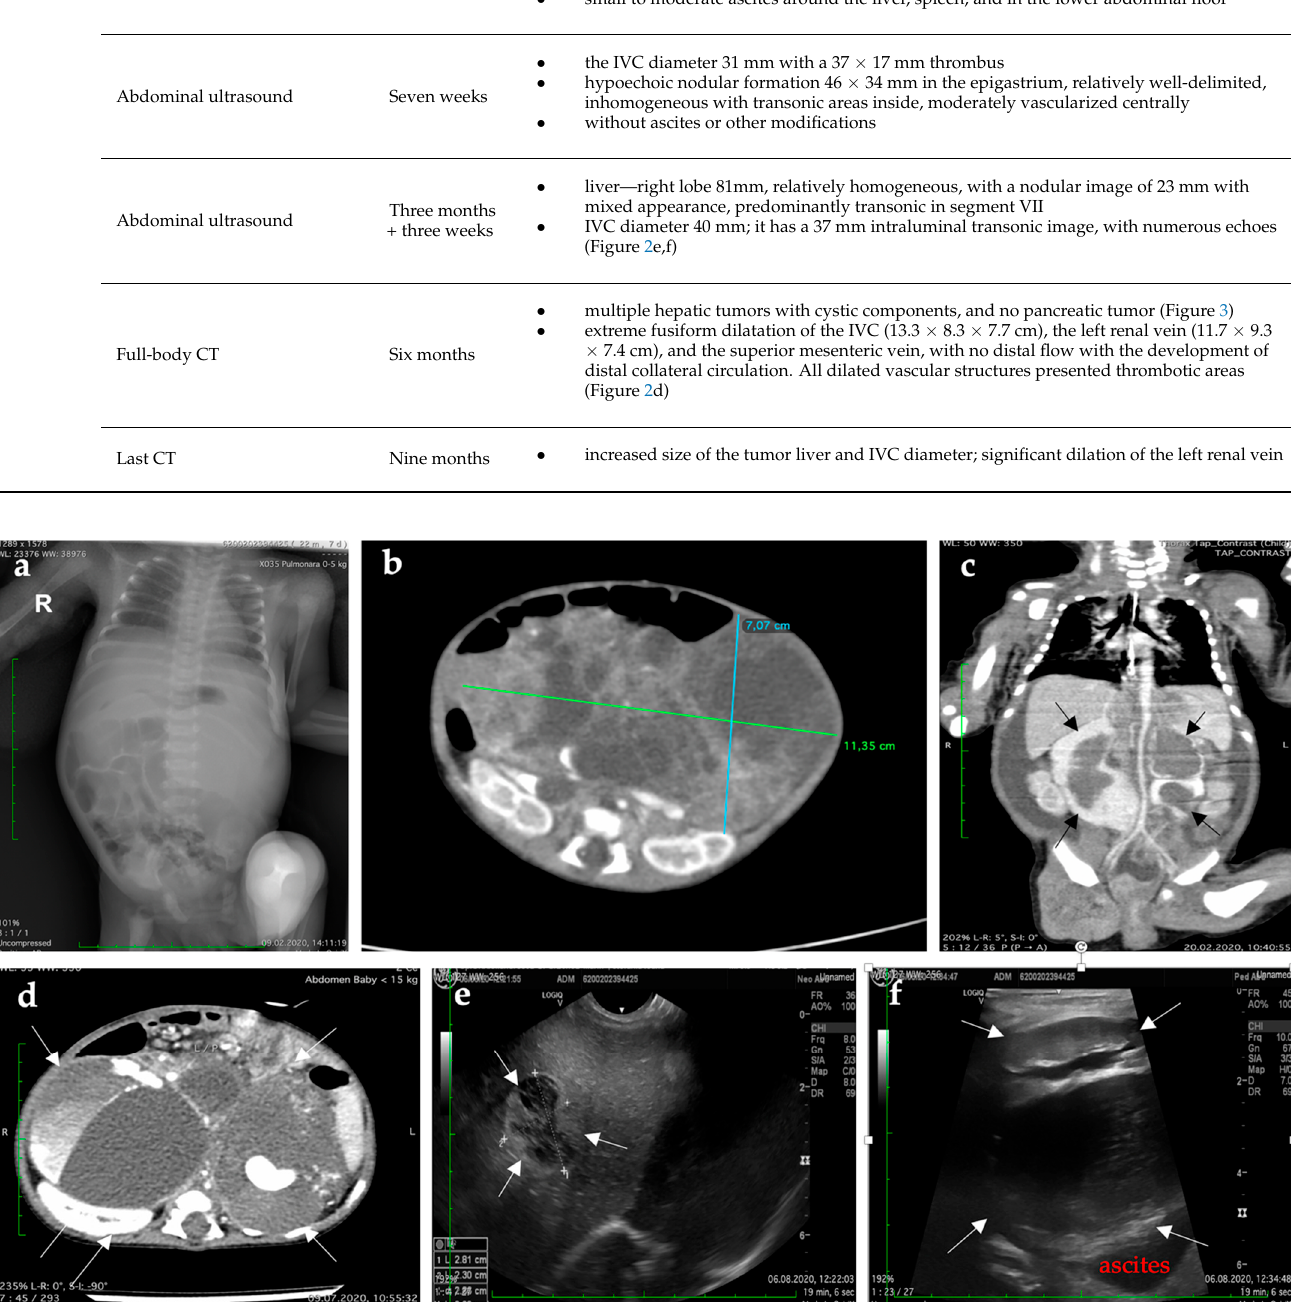
ileal loops on which has a mass effect; nodular mass in the Vth segment of the liver, under the hepatic capsule, size < 1 cm, firm consistency suggestive for metastatic nodule; mes- entery tumor mass, 1 × 1 cm, with a consistency similar to the pancreatic tumor (Figure 3).